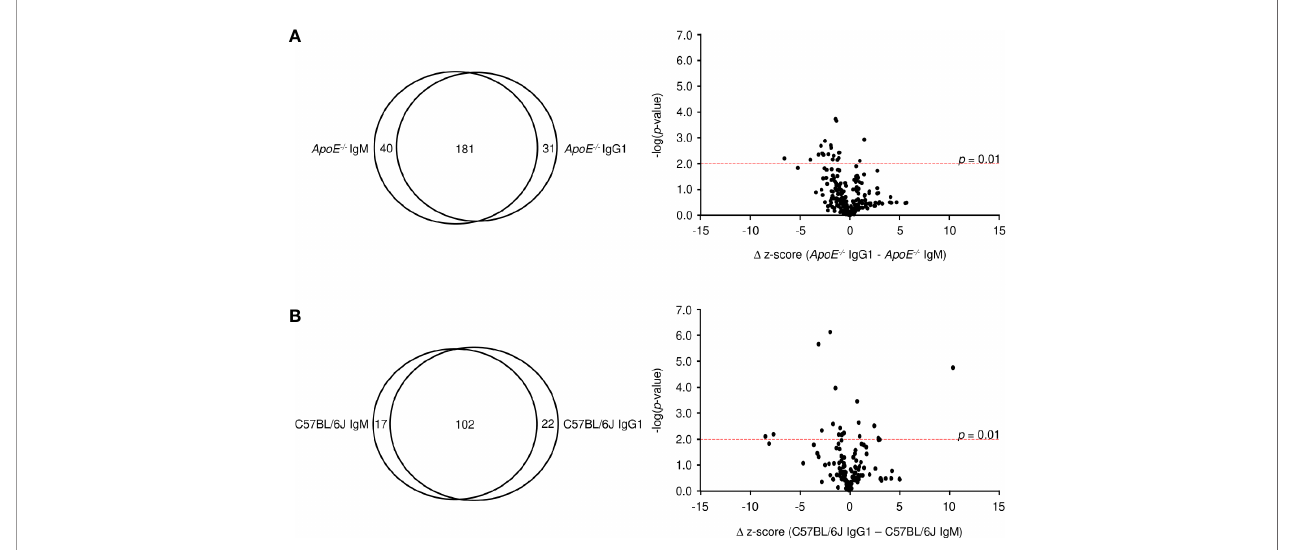
FIGURE 5 | Comparative analysis of IgM and IgG1 antibodies. Venn diagram and volcano plots comparing signi fi cant protein targets for IgM and IgG within (A) ApoE -/- and (B) C57BL/6J serum. Red dashed line represents a p-value of 0.01 determined by two-tailed T